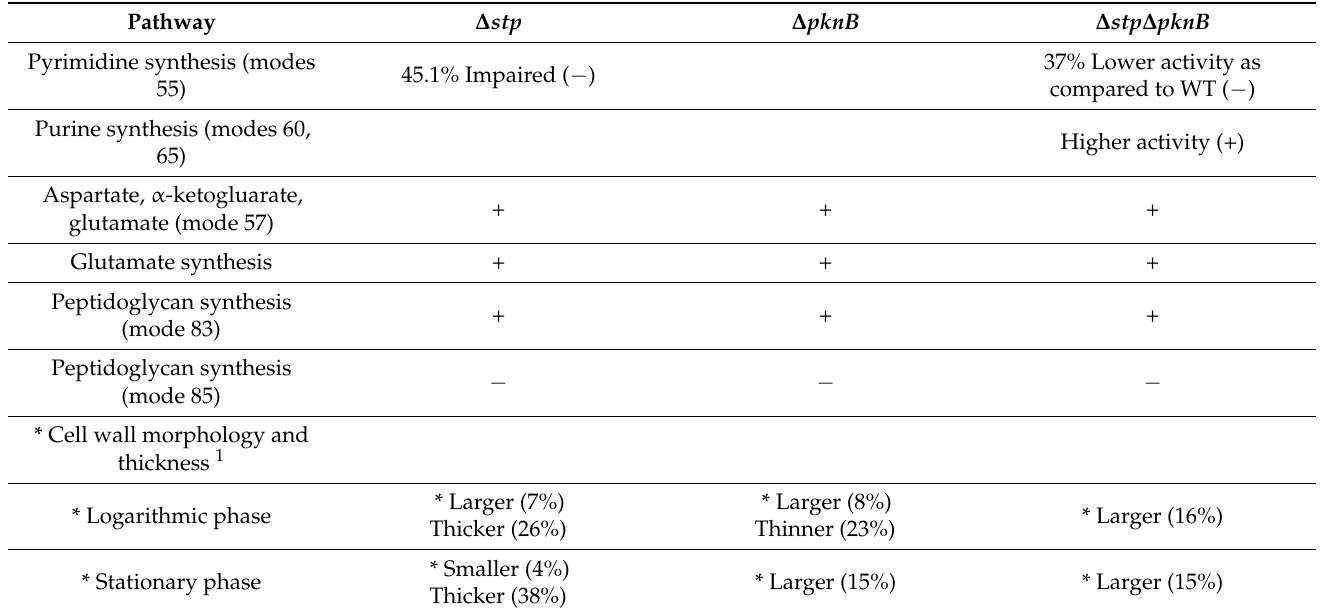
Table 3. S. aureus NewHG metabolic changes under pknB / stp